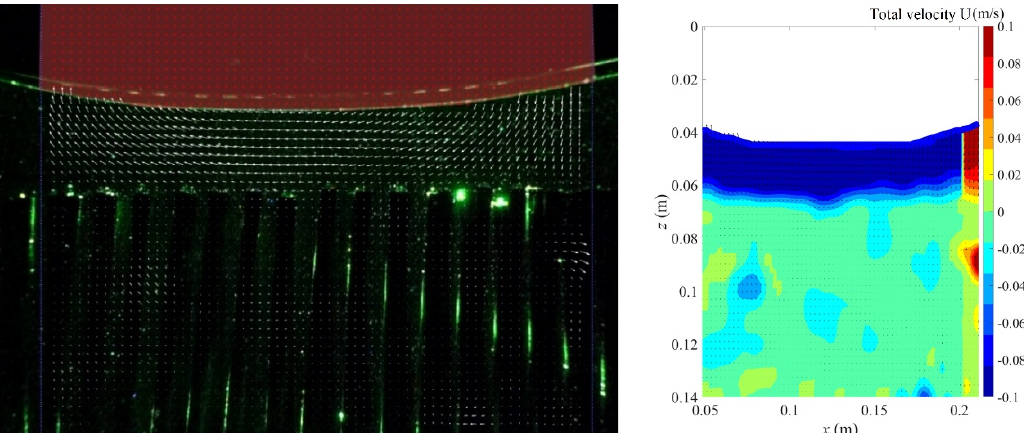
Figure 5. Velocity field and distribution of a short-period wave trough ( T = 0.5 s) passing through vegetation structures ( ϕ = 0.5 cm and d = 10 cm).